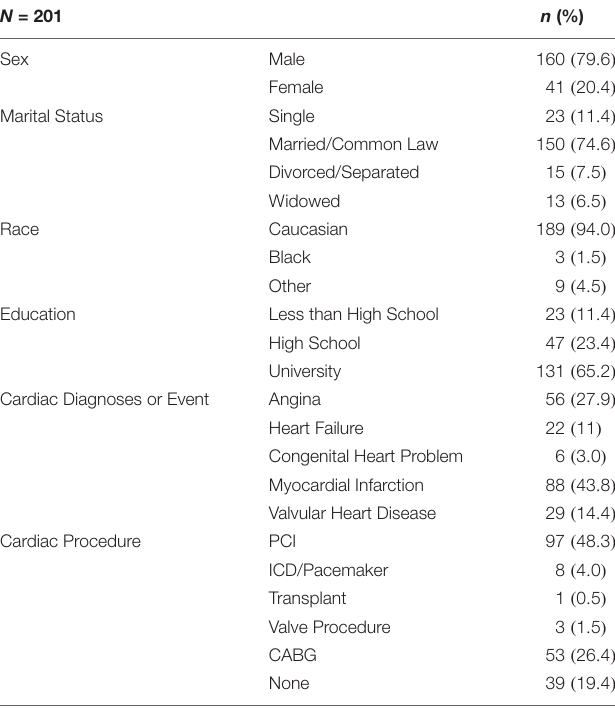
TABLE 1 | Demographic characteristics of